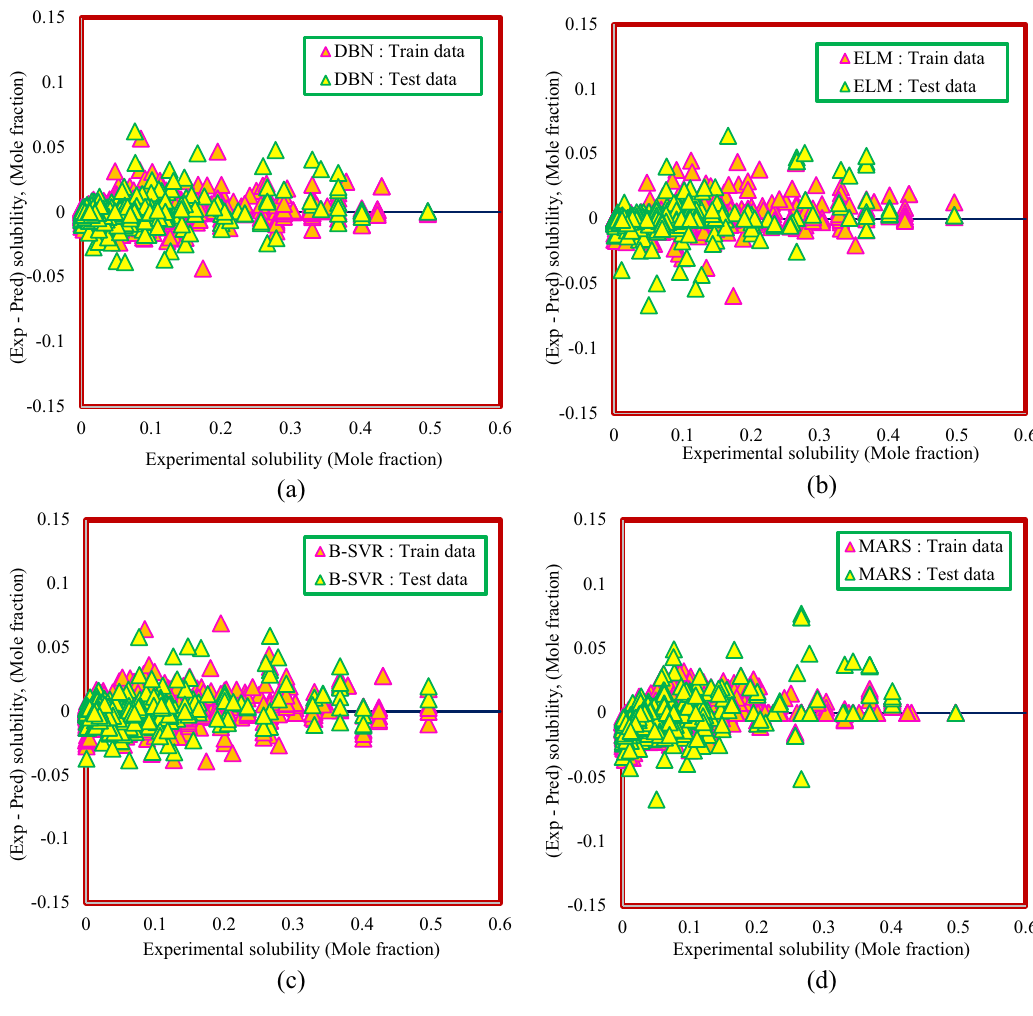
Figure 11. Distribution of deviation of predicted values from actual values for Model (II): ( a ) DBN model, ( b ) ELM model, ( c ) B-SVR model, ( d ) MARS